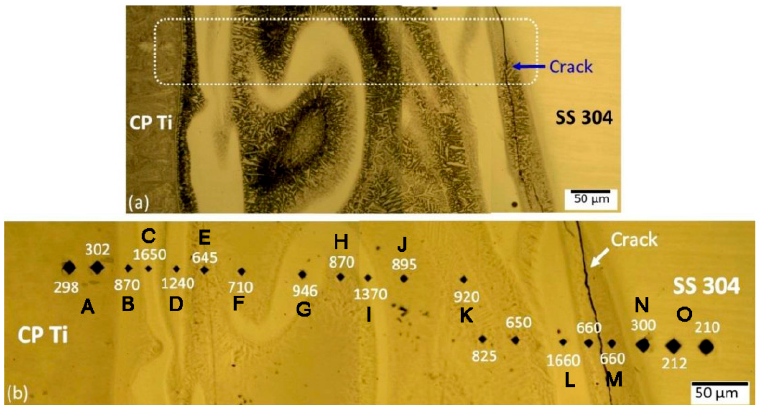
Figure 3. Optical micrographs of LBW showing ( a ) a distinct solidification pattern with the dashed line box indicating the area of interest for hardness measurements, chemical composition analysis and phase identification, and ( b ) the hardness distribution within the dashed line box area. The compositions of labels A-O are overlaid in the phase diagram (Figure 6) [11].